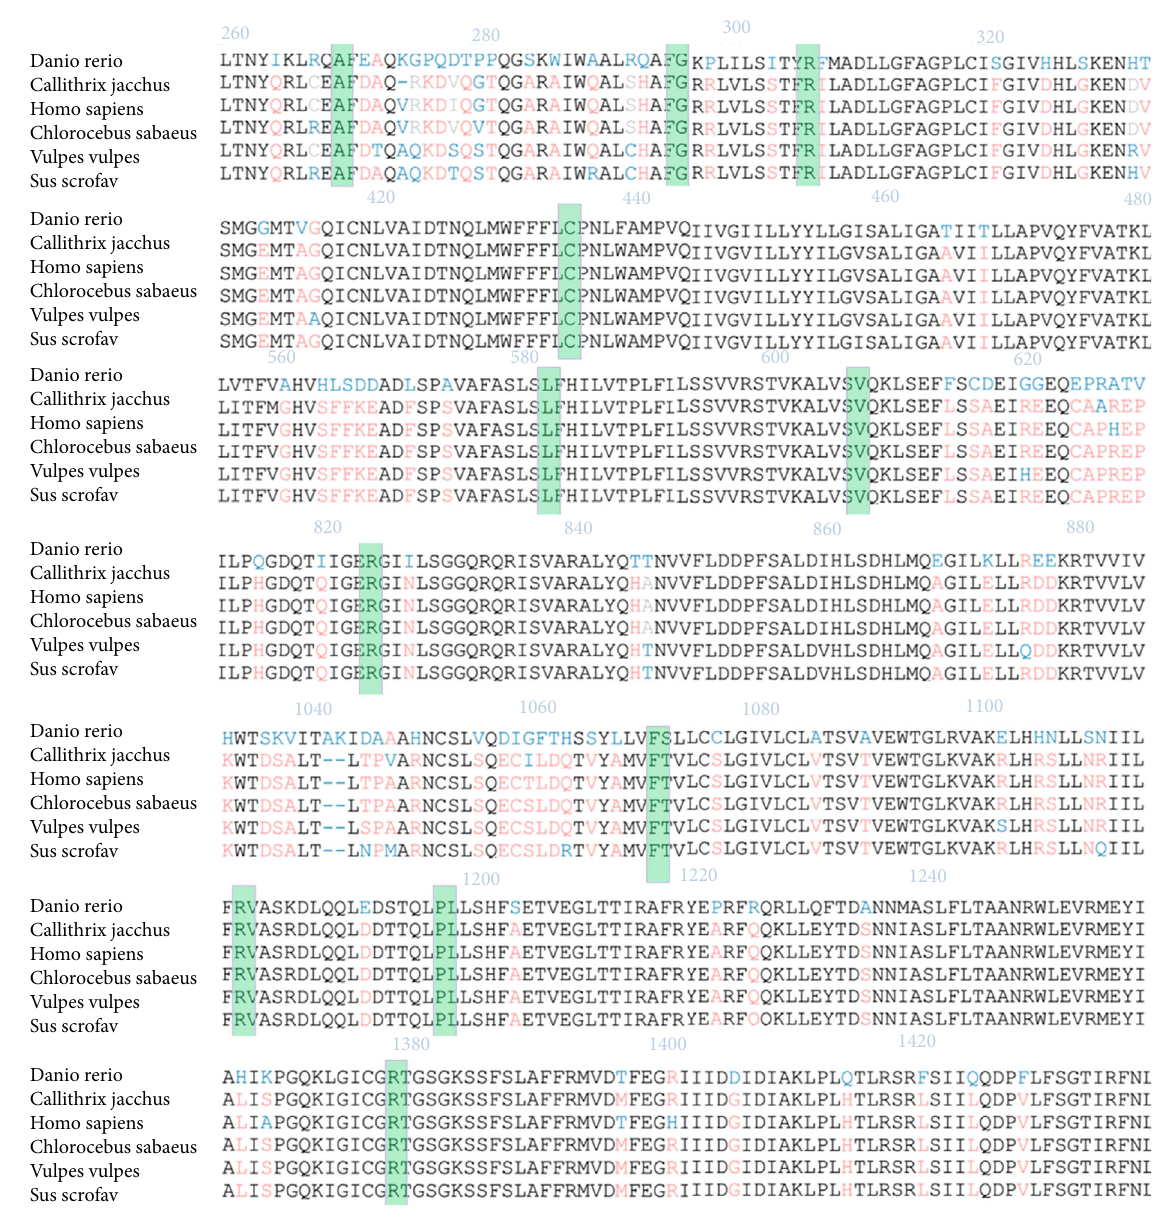
Figure 2: Multiple sequence alignment of the ABCC8 gene. Multiple sequence alignment of ABCC8 of a vertebrate species including Homo sapiens was analyzed. The black font represents strictly conserved amino acid residues, while sites with sequence identities of 70% or more are in red. Twelve variants identi fi ed through this study are highlighted in